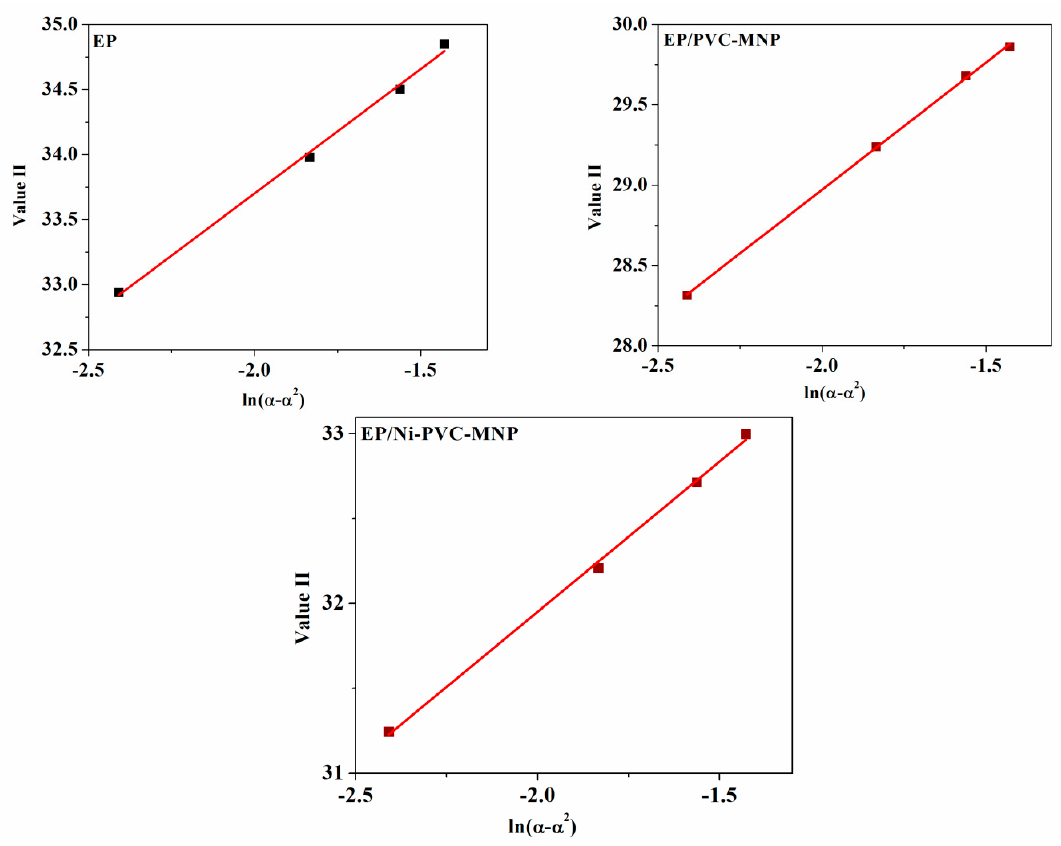
Figure A5. Value II of the samples at 5 °C/min.